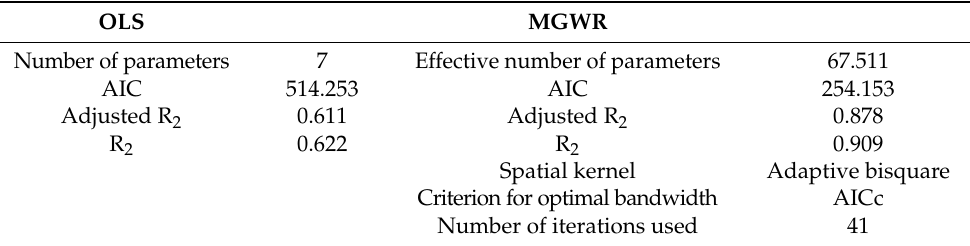
Table 5. Summary of MGWR model output.